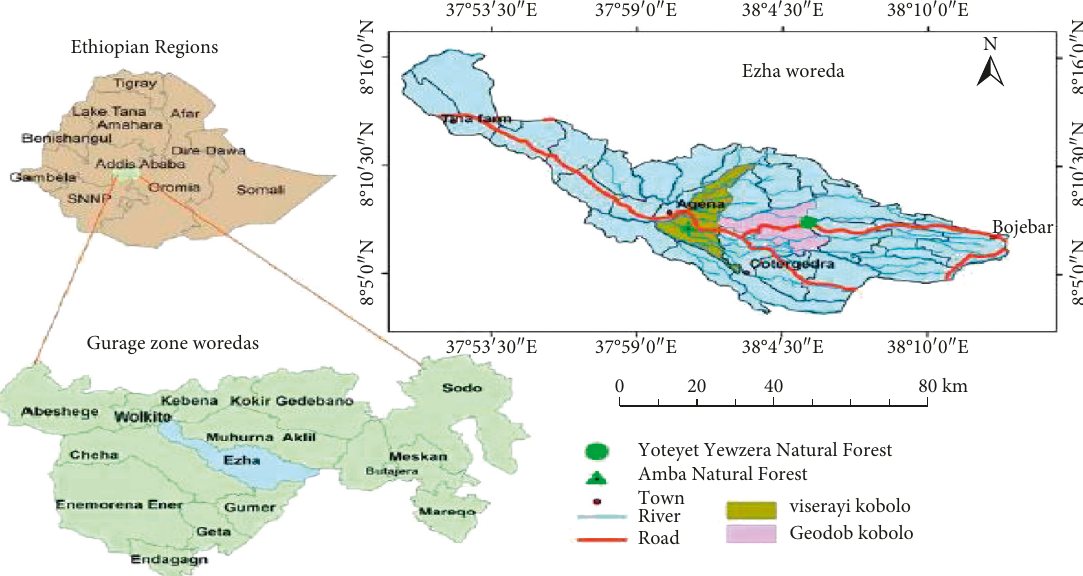
Figure 1: Map of Amba forest (study area) [28].